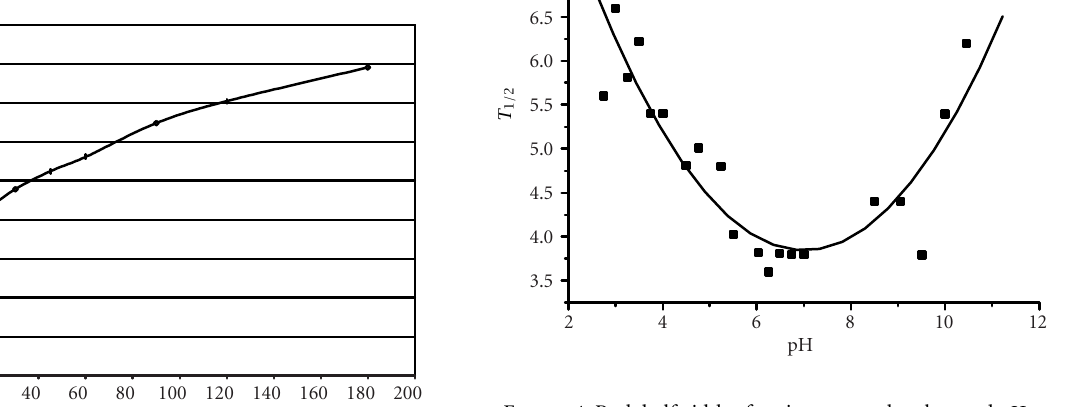
least variation in scanrate dependence has been observed.